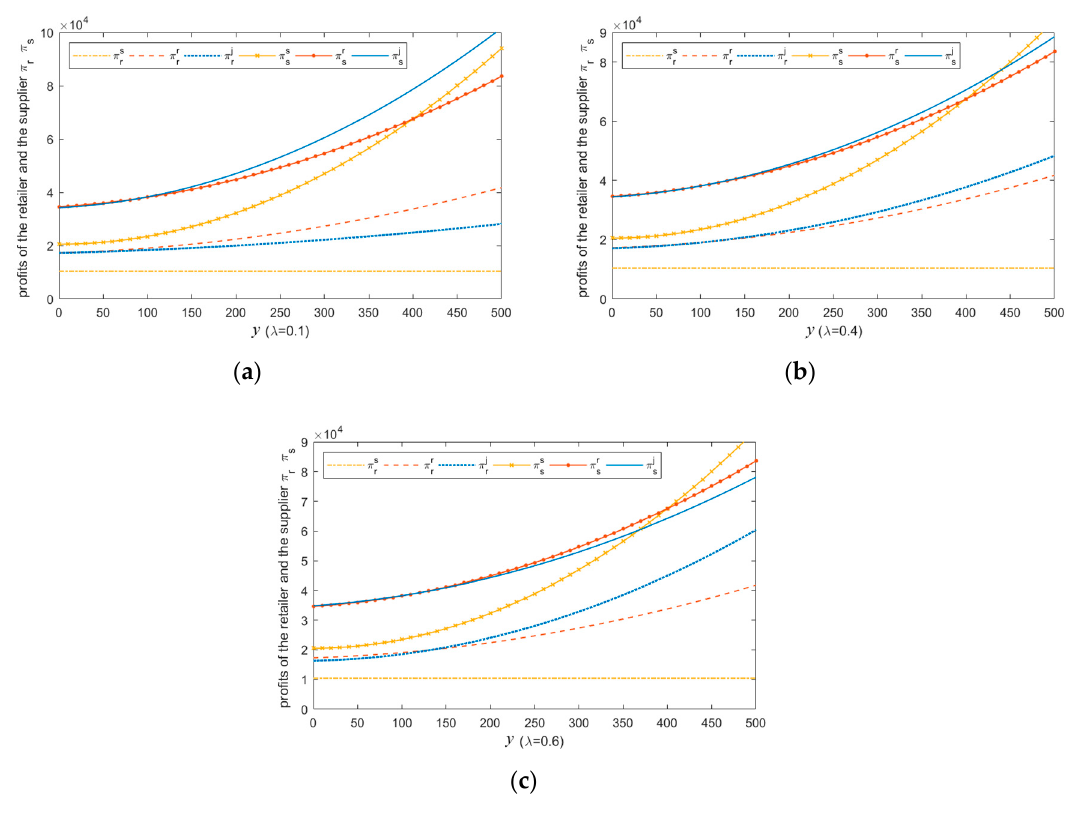
Figure 5. Profit of the retailer and supplier with respect to y under three strategies when λ = 0.1 ( a ), λ = 0.4 ( b ) and λ = 0.6 ( c )